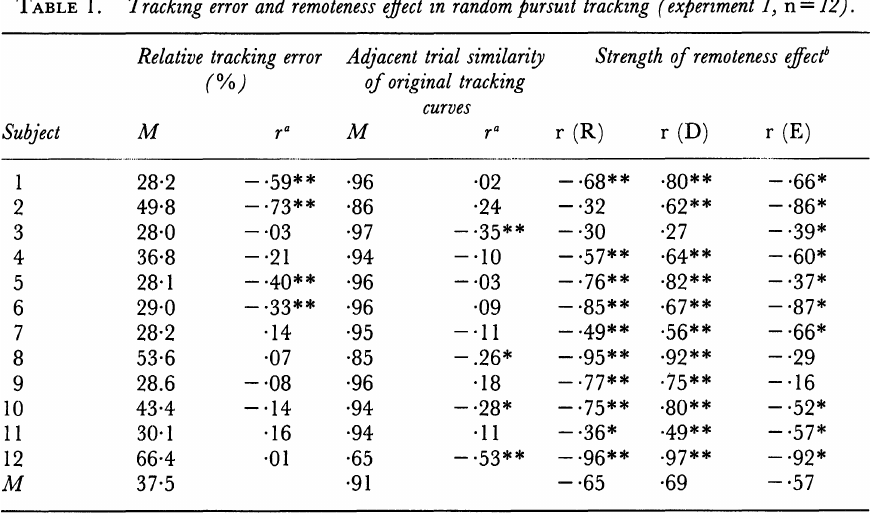
"Rank correlation with trial number. • Similarity measured (R) by point-to-point correlation of error curves, (D) by point-to-point difference.